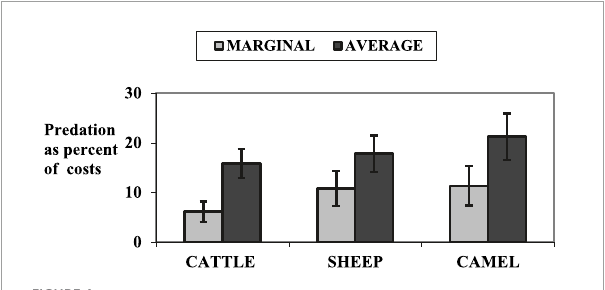
FIGURE4 Predation as percent (+ SE) of annual costs of rearing livestock on twenty Laikipia commercial ranches in 1995–1996 (Marginal: F = 1.03; df = 2.40; p = 0.36. Average: F = 0.50; df = 2.40; p = 0.61).